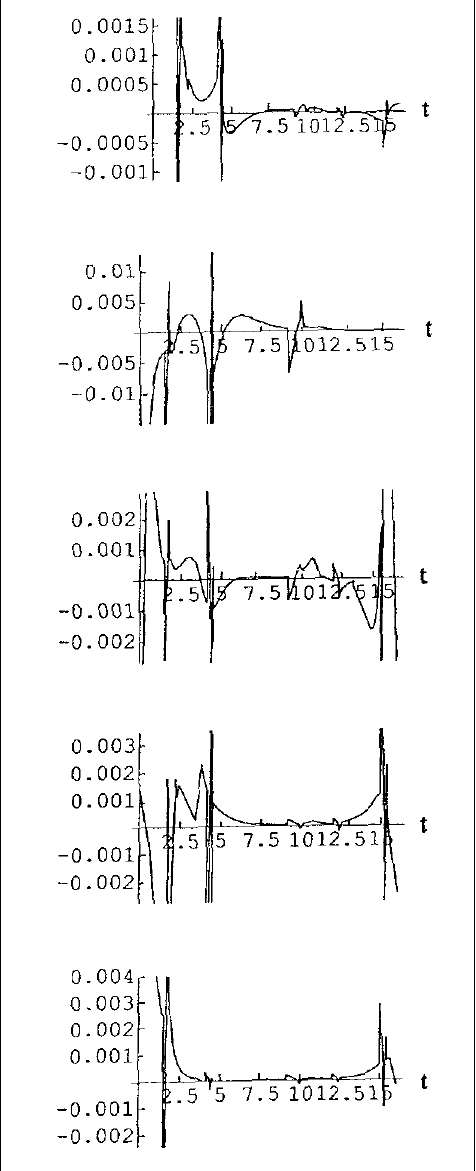
Fig. 1. Source intensities of electromagnetic induction field (cid:95) (x,t) (cid:95) 10 17 [1/m 2 s]; for x [10 (cid:60) 5 s].